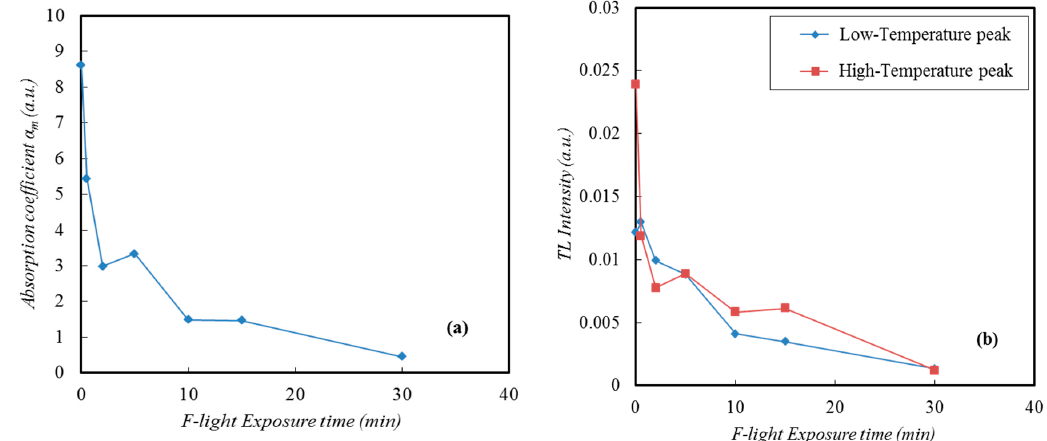
Figure 10. Variations of ( a ) absorption coefficient and ( b ) each peak on TL glow curve of X-ray irradiated (irradiation time: 6 min) KCl:Eu 2+ (0.1 mol%) single crystals with F -light (excitation bandpass: 20 nm) exposure time.